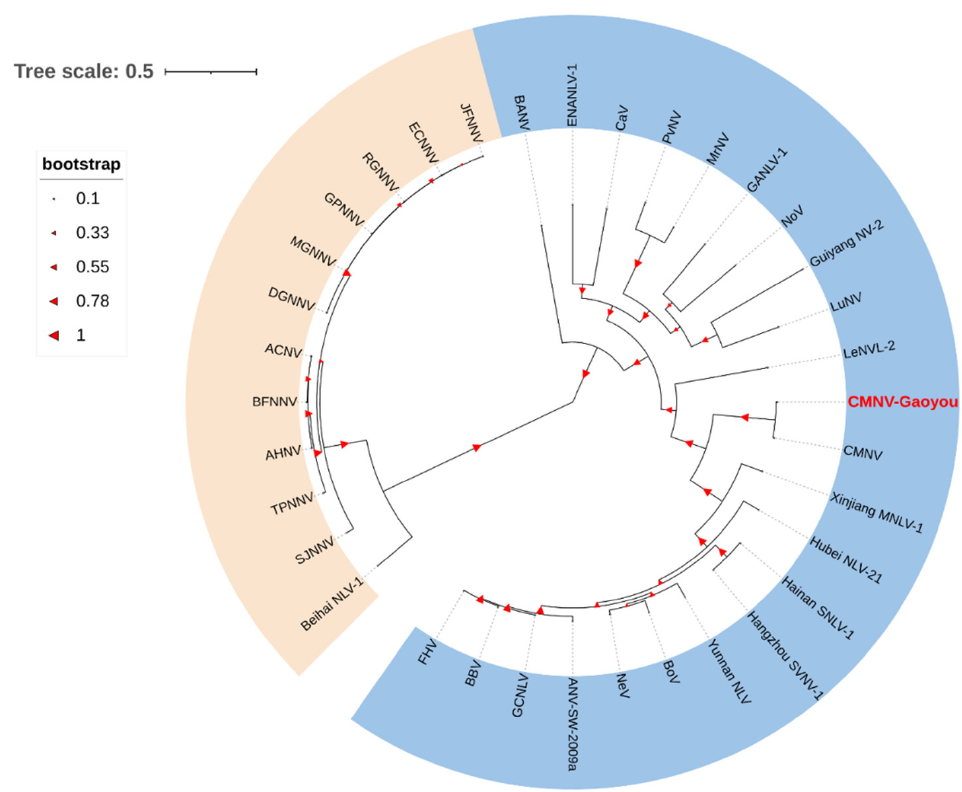
Figure 1. Phylogenetic tree analysis of the RdRp amino acid sequences of both covert mortality nodavirus (CMNV) isolated from Macrobrachium rosenbergii samples and other Nodavirus species (Table 1). CMNV isolate of M. rosenbergii sampled from Gaoyou, Jiangsu province is marked by red font. Species of Alphanodavirus and Betanodavirus are shown in blue and orange background, respectively. The phylogenetic tree was built using the MEGA 6.0 program based on the neighbor- joining method. The scale bar is 0.5. The bootstrap value was 1000 replicates, and the larger the bootstrap value, the higher the confidence of the